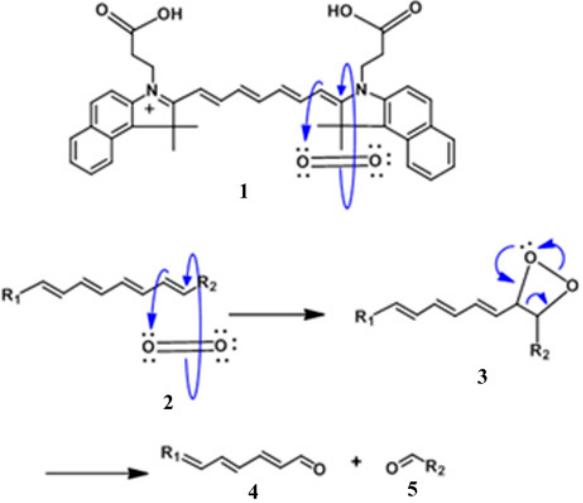
Figure 1. Mechanism of the photobleaching of Cypate by singlet oxygen. This illustrates the photobleaching that occurs in vitro and in vivo following absorbance of light in the near-infrared (NIR) region of the